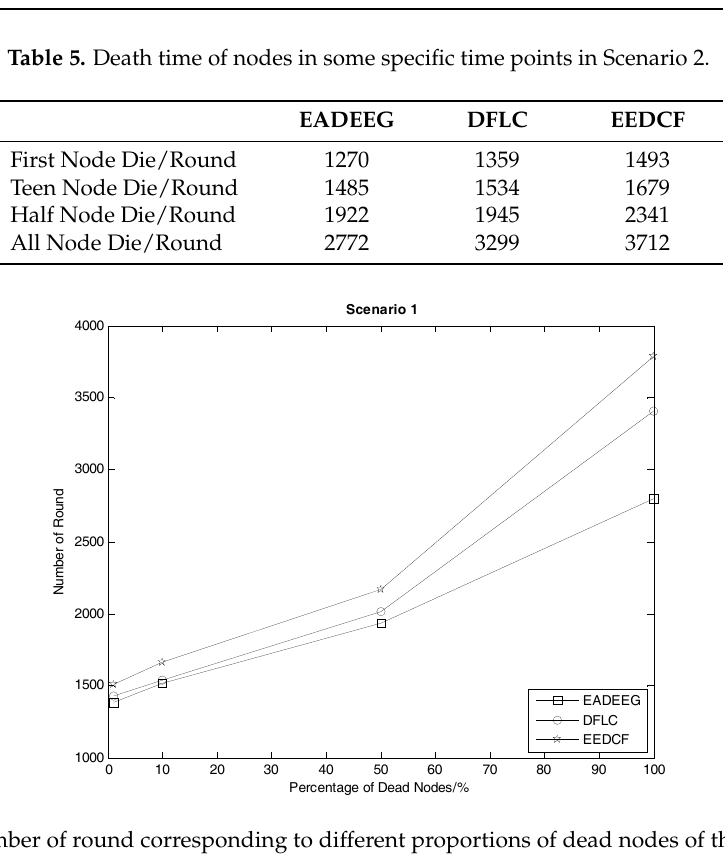
Figure 10. Number of round corresponding to different proportions of dead nodes of the network in Scenario 2. Network energy consumption is a major factor in reflecting network performance. The system life cycle is also directly affected by the energy consumption of the networks. Figure 11 compares the energy consumption of the three algorithms in Scenario 1. From EADEEG to DFLC, and to EEDCF, the gradient of energy consumption curves is gradually slowing down, which is due to the usage of the fuzzy logic algorithm and increasingly reasonable optimization of CH election mechanism. We also extracted the real-time residual energy data of some designated rounds from Figure 11, and they are shown in Table 6. In the 1500th round, the total residual energy in EEDCF is 2.94 J more than that in DFLC, and 6.60 J more than that in EADEEG. In the 2000th round, the total residual energy in EEDCF is 3.05 J more than that in DFLC, and 7.44 J more than that in EADEEG. As we can see, the energy gaps between the three algorithms become bigger and bigger with the increase of round. Moreover, the proposed algorithm considers the load balancing problem in multi-hop communication mode, and introduces neighbor nodes’ residual energy as the additional